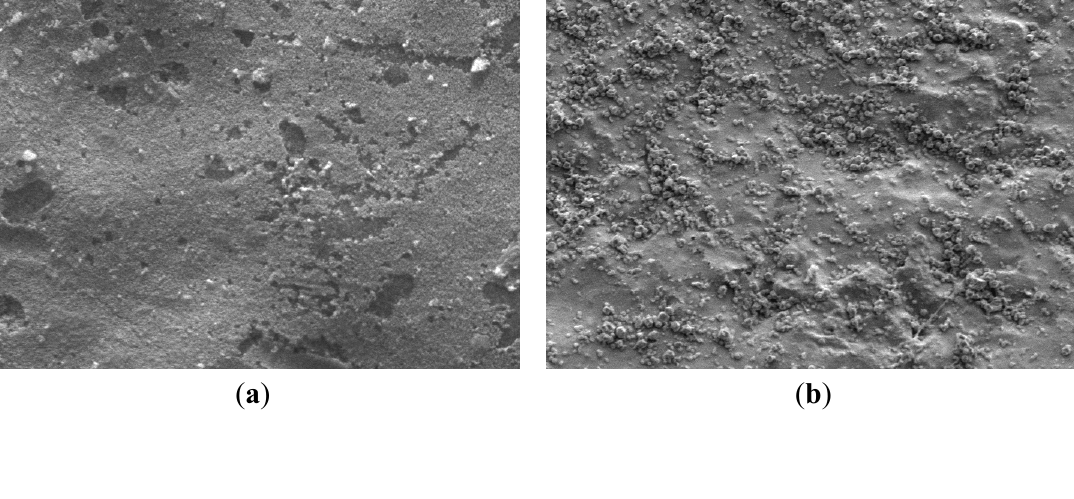
Figure 4. SEM images of clean membrane and retentates of suspensions containing different concentrations of S. cerevisiae ( a ) clean membrane; ( b ) S